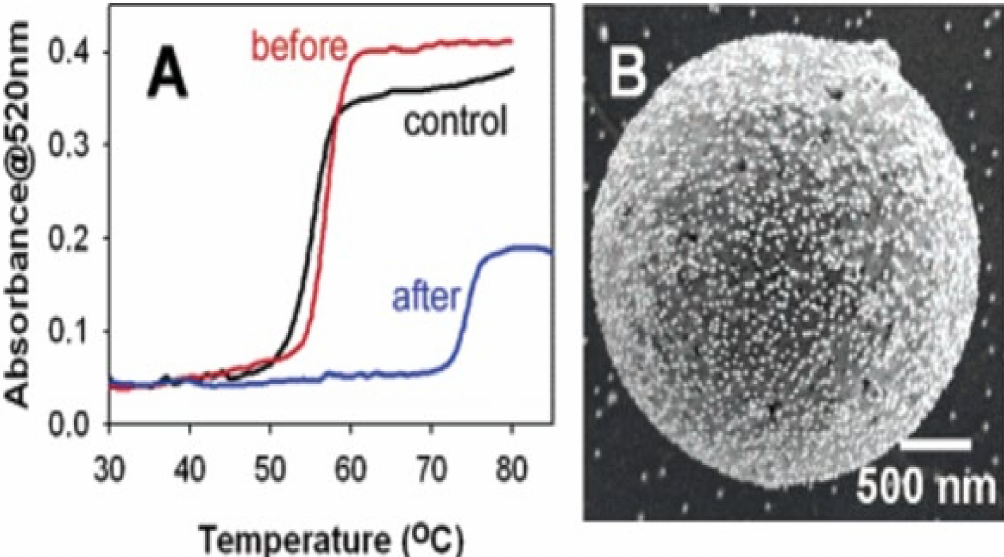
Figure 48. ( A ) 13 nm Au NP DNA melting curves hybridized by delay DNA with MMPs. The ligation stage increased dramatically, from 54 ◦ C to 74.5 ◦ C, before (red), after the melting temperature (blue). The ligation stage showed limited impact in addition to the extension DNA (black curve). ( B ) The 30 nm Au NP SEM picture on an MMP’s surface. Reproduced with permission from reference [338], Copyright 2005,